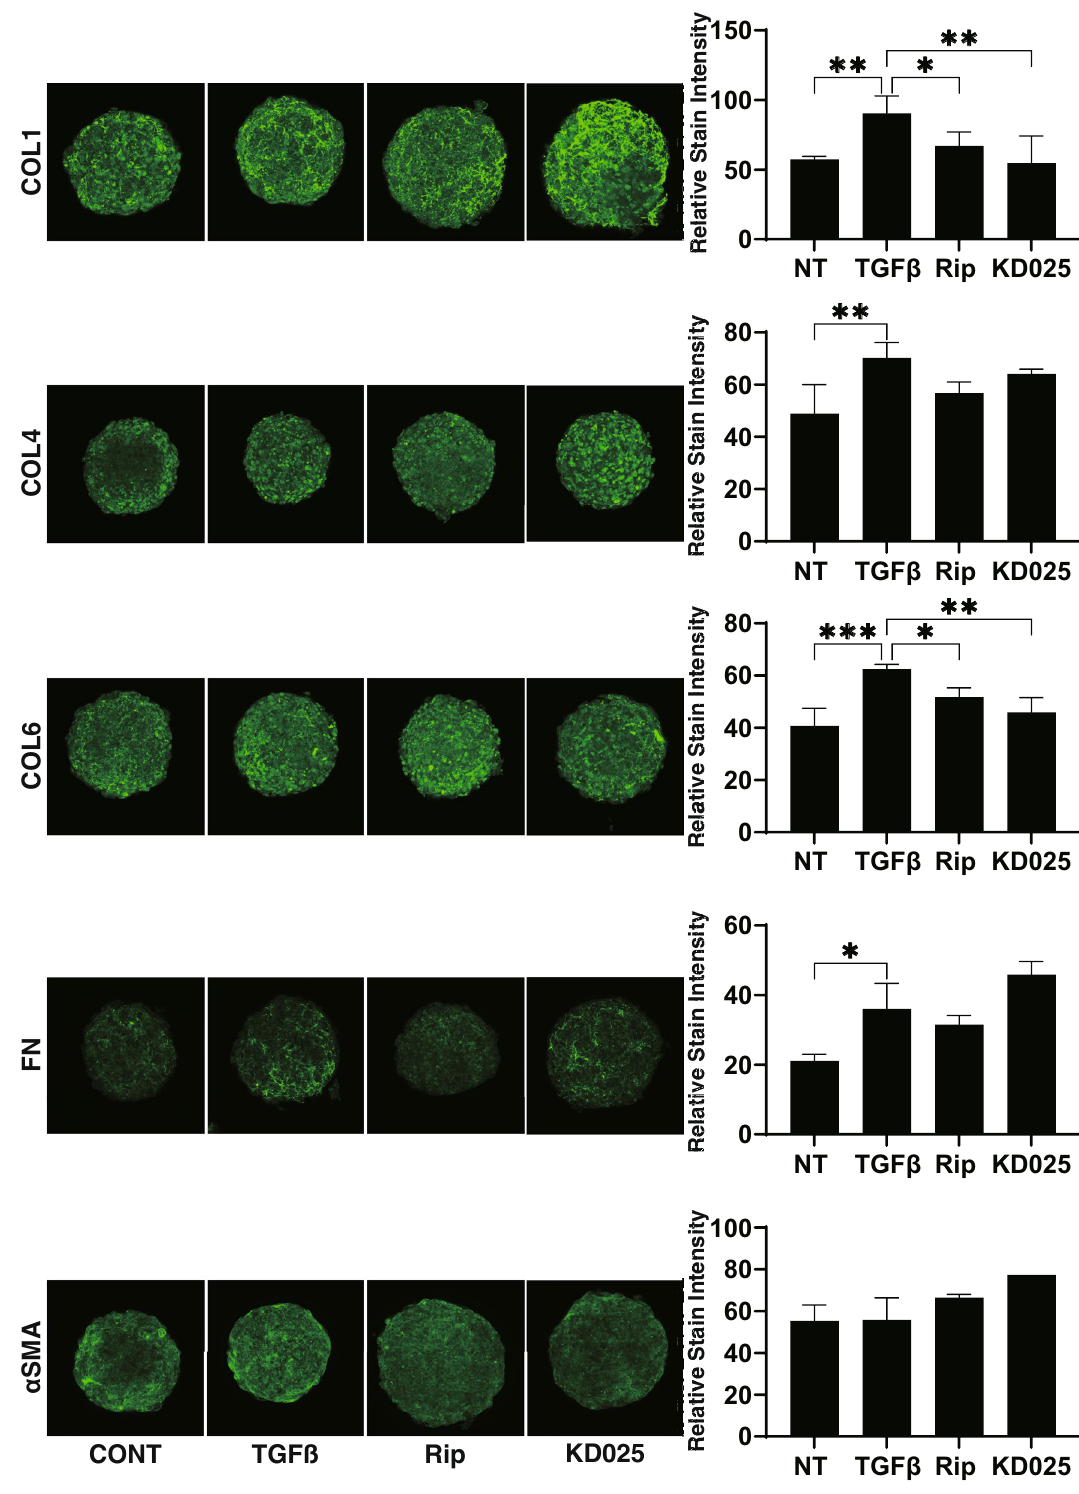
Figure 5. Immunostaining of ECMs of the 3D HTM sphenoids. At Day 6, 3D HTM sphenoid (non-treated control) and those treated by 5 ng/ml TGFβ2 in the absence or presence of 10 μM ripasudil (Rip) or KD025 were subjected to immunostaining for COL 1 , COL 4 , COL 6 , FN and a-SMA . All experiments were performed in duplicate using fresh preparations (n = 4). Representative images are shown in left panels and relative staining intensities were plotted in right panels. Data are presented as the arithmetic mean ± standard error of the mean (SEM). * P < 0.05, ** P < 0.01, *** P < 0.005 (ANOVA followed by Tukey’s multiple comparison